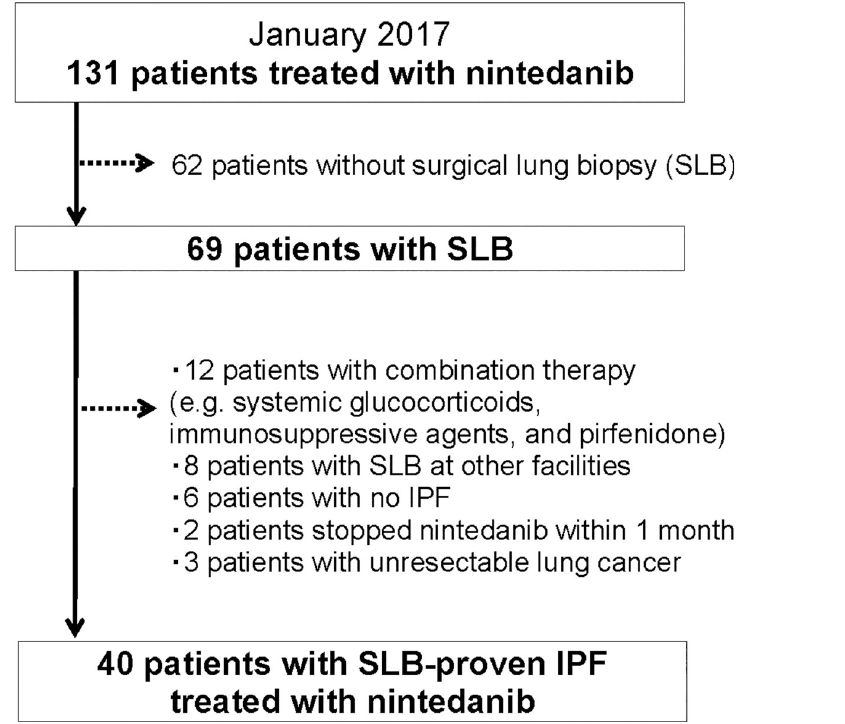
Fig 1. Patient selection flow chart.